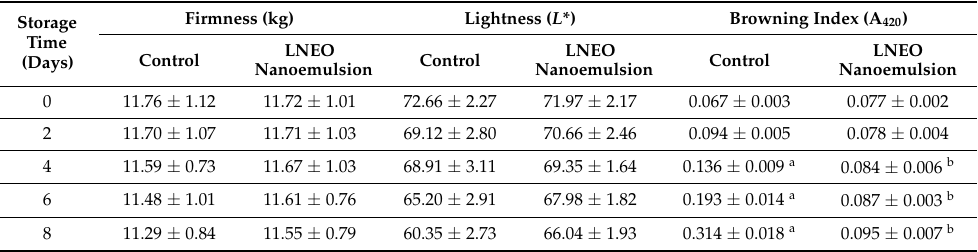
Table 1. Effects of LNEO nanoemulsion on firmness, lightness and browning index in fresh-cut